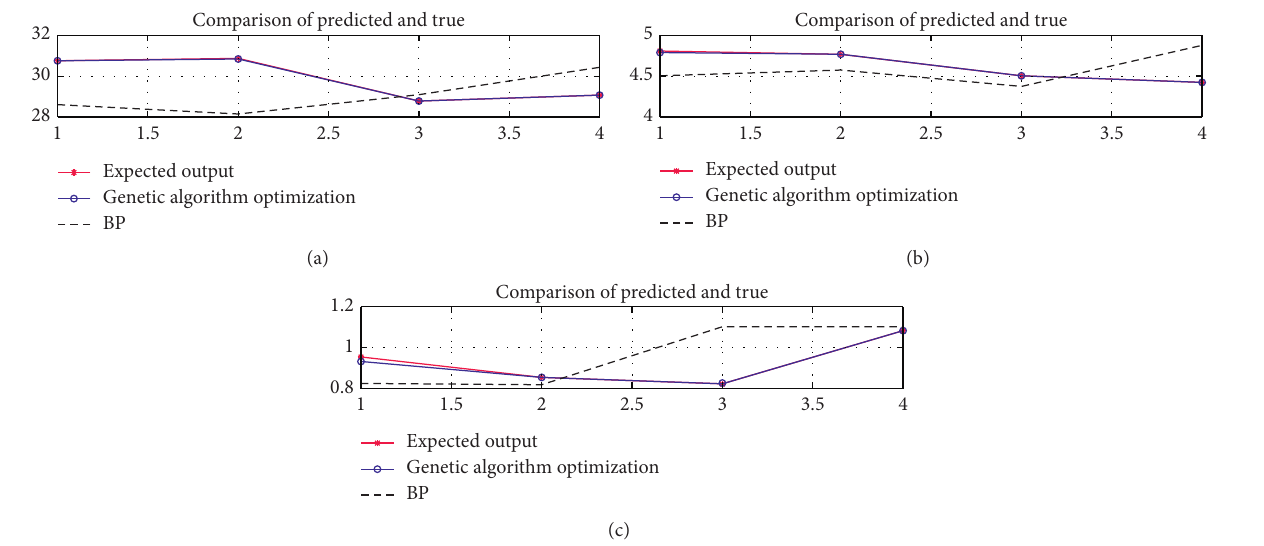
Figure 22: Comparison of predicted and experimental